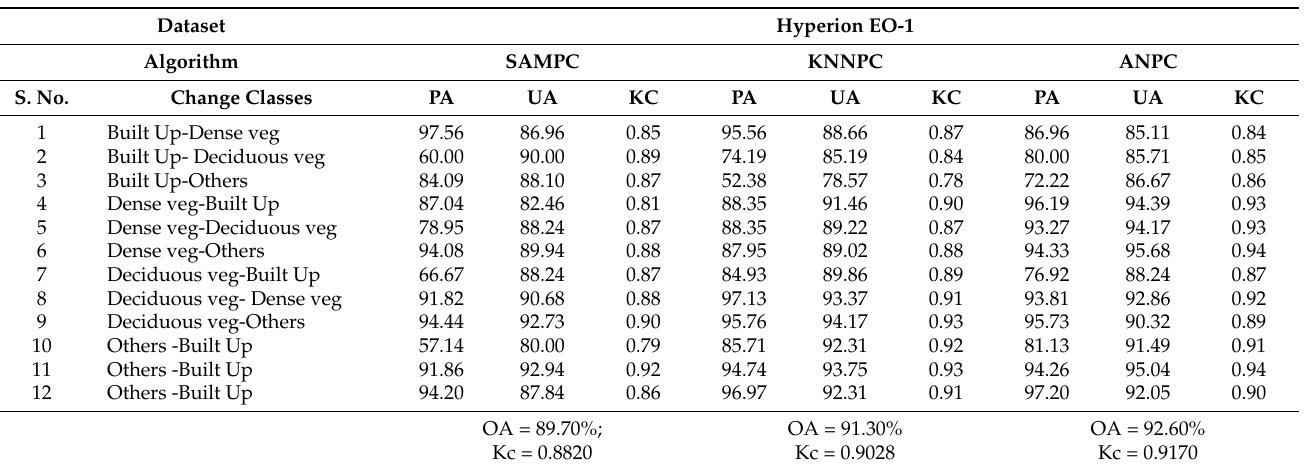
Table 2. Accuracy Assessment of change maps computed from SAMPC, KNNPC, and ANPC using